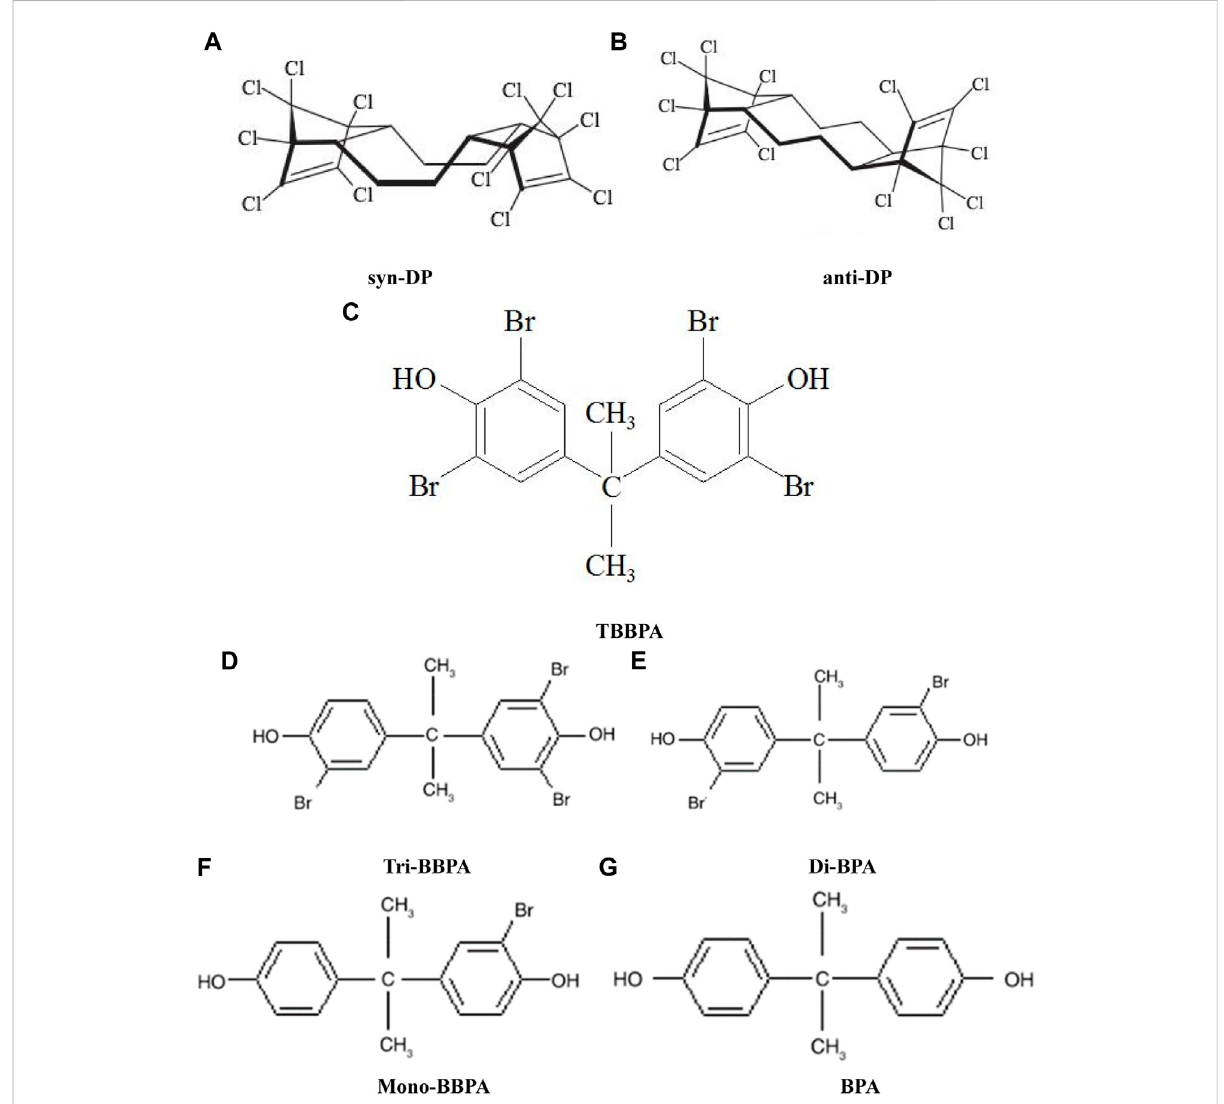
FIGURE 1 The molecular structure of syn-DP, anti-DP, and TBBPA. (A) syn-DP, (B) anti-DP, (C) TBBPA, (D) Tri-BBPA, (E) Di-BPA, (F) Mono-BBPA, (G)